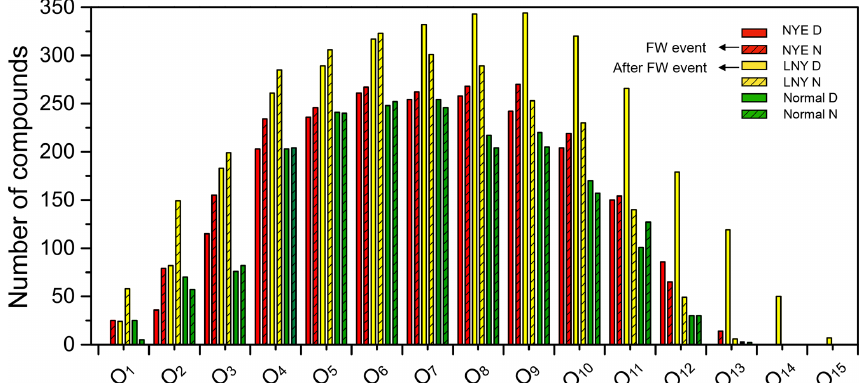
Figure 3. Classification of CHO species into subgroups according to the number of O atoms in their